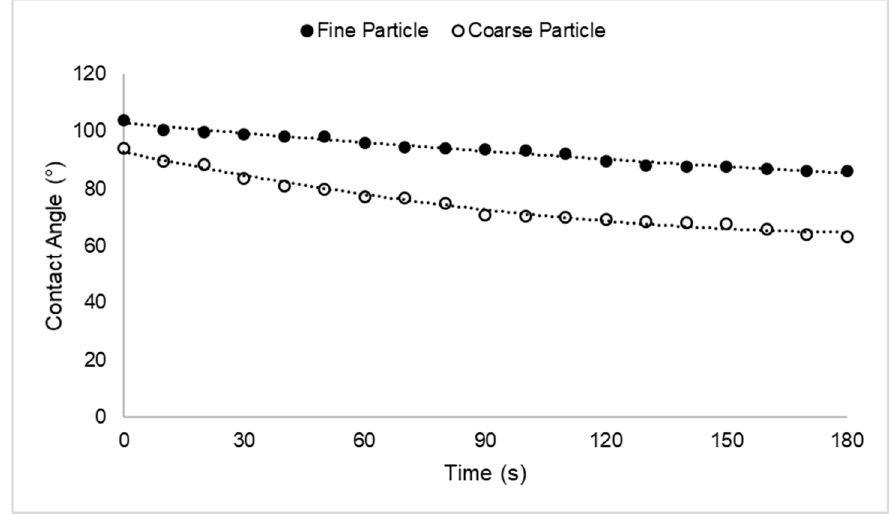
Figure 6. The dynamic wetting process as shown by the contact angle (°) with